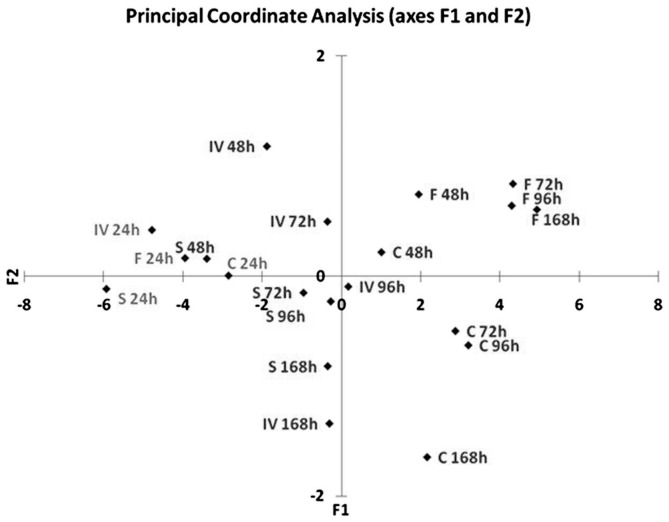
Scatter plot of the first two principal components from the Principal Coordinate Analysis of the carbon source utilization profiles of conidia conidia isolated from the four trophic phases (in vivo-IV, sapro-S, flask-F and chemo-
C) after 24, 48, 72, 96 and 168 h of incubation.